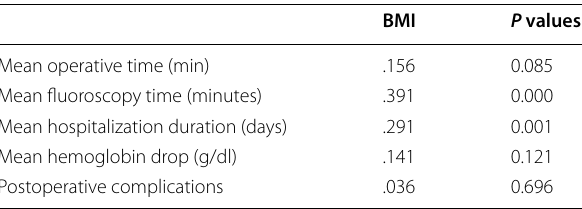
Table 4 Correlation between BMI and operation outcome (univariate and multivariate analysis) BMI P